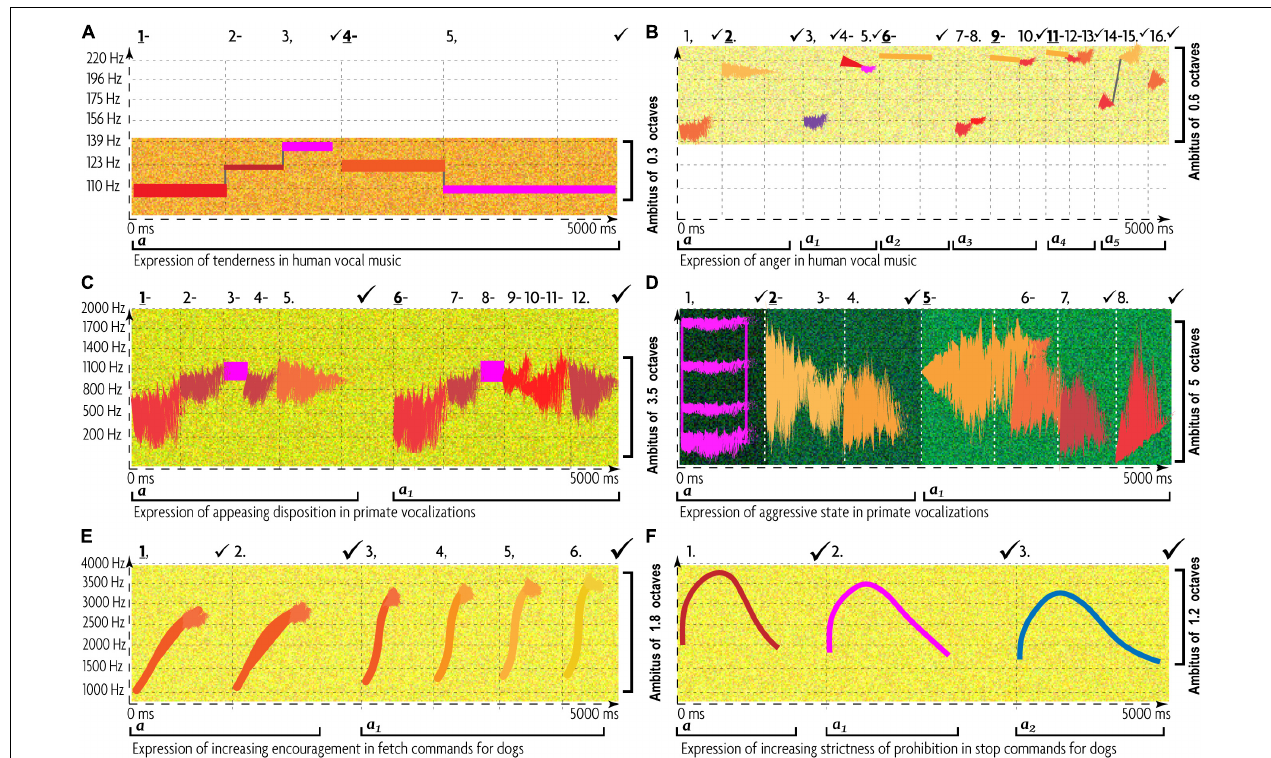
FIGURE 5 | Hybridization of characteristic patterns of ACs and human music in encouraging and prohibiting commands by human trainers to their dogs (McConnell and Baylis, 1985; McConnell, 1990, 1991, 2002; Miklosi, 2015). (A) Typical expression of tenderness in human music . This diagram extracts the key features of Table 2 and Figure 2 : very few pitch-classes with a low rate of change within a narrow ambitus, wave-like melodic contours filled by stepwise motion in the low register, slow tempo, with long tones and tendency to decelerate, and regular meter yet rhythmic diversity. Articulation is mostly legato, with occasional pauses. Dynamics is soft, stressing the anchor tones. (B) Typical expression of anger in music (according to Table 2 and Figure 3 ): many pitch-classes with high rate of change and wide ambitus, ascending contours, and leaping zigzagging motion in high register. The tempo is fast, with short tones, often accelerating, with irregular pulse, and strong rhythmic contrasts. Dynamics is mostly loud, and accents fall on metrically weak tones. (C) Typical expression of appeasing disposition in primate vocalizations ( Table 3 ). Many pitch-levels have a high rate of change, following a gradually ascending melodic contour within a relatively narrow ambitus. Tempo is fast, with short tones and long groupings. These features strongly contrast (A) , whereas metric regularity, legato articulation, low registration, and soft dynamics resemble (A) . (D) Typical expression of aggressive disposition in primate vocalizations ( Table 3 and Figure 4 ). There are relatively few pitch changes due to an extremely broad bandwidth, precluding frequent leaping. Long tones are embedded in fast motion with a descending contour in low register. These features oppose (B) , whereas meter, articulation, dynamics, and harmonicity resemble (B) . (E) Typical expression of growing encouragement in fetch-whistles for dogs . This expression combines a tender disposition of a human (A) with the appeasing disposition of a dog (C) . Therefore, fetch-command has to reconcile the contradictions between AEs’ expressions of (A) and (C) . To accomplish this, the ascending contour becomes steeper, each signal and the time interval between signals become shorter, the ambitus of each signal grows and reaches higher register, and the groupings grow in size (from 2 to 4). Temporal and pitch AEs are co-adjusted, merging traits from (A) and (C) . (F) Typical expression of growing prohibition in stop-whistles for dogs . This expression combines the display of human displeasure, like (B) , with the appeasing disposition of the dog (C) , while structurally and semantically opposing (E) . (F) subverts a single long tone to the contrasting gradual flections in pitch, where the descending portion receives the greatest significance. The increase in intensity of prohibition is signified by extending the time values and reducing the steepness of the descending curve—in contrast to (E) . Dynamics provides yet another axis of opposition: loud for (E) versus soft for (F) . Most importantly, the (E,F) opposition involves a compensatory interaction of the temporal, dynamic, and pitch patterns of AEs. Thus, whenever (F) is used in isolation, its softness, slowness, and ametricity might project the impression of passiveness—contrary to the categorical nature of a “stop” command. To avoid this, (F) ’s melodic curve combines ascending and descending curves whose conflicting relation generates extra tension.